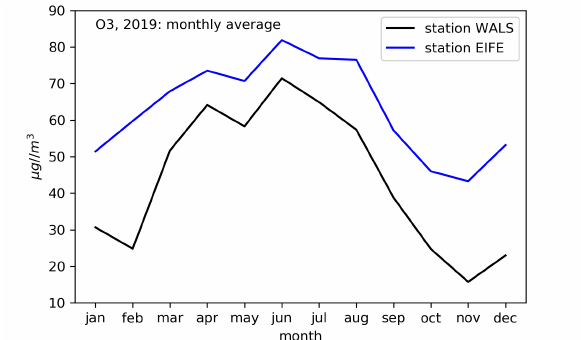
Figure 3. Monthly average values of O 3 (year 2019) for the urban station WALS and the rural station EIFE. Other factors are complex chemical reactions, such as 1 O 3